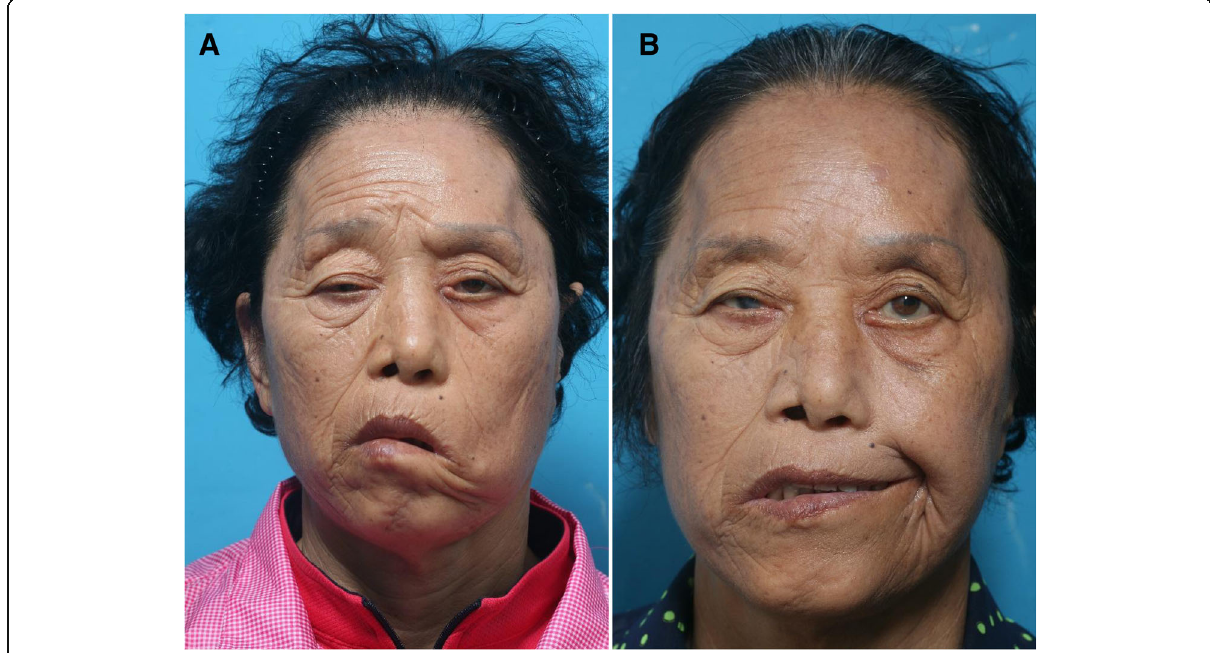
Fig. 4 Clinical photos (pre-operation a , 6 months after operation b